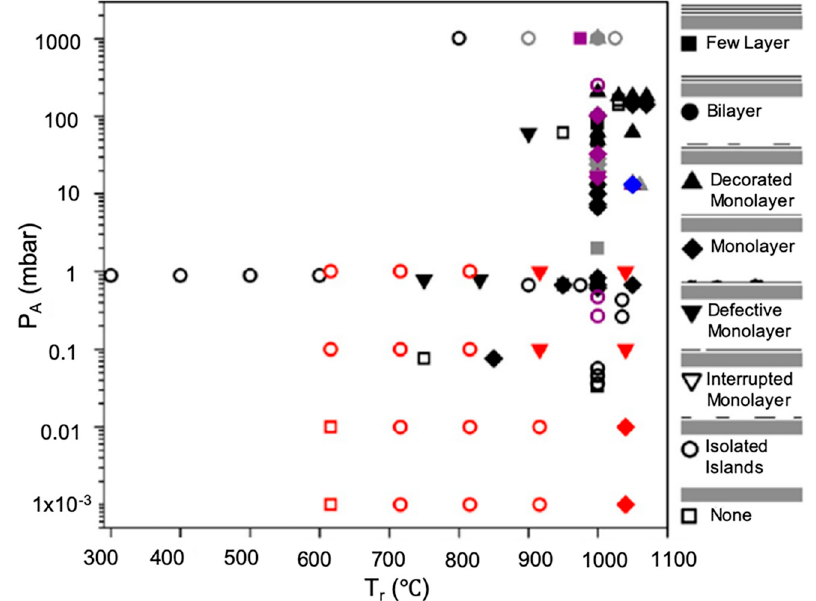
Figure 5. Coverage type for CVD of graphene versus growth temperature and pressure of active species as reported in the literature and Lewis et al. study. The data points span a range of different R CH denoted by the color: black: 1 > R CH > 0.1; gray for 0.1 > R CH > 0.01; purple for 0.01 > R CH > 0.001 and blue for 0.001 > R CH > 0.0001. The red data points correspond to the work done by Lewis et al., where R CH = 0.2 (reprinted with permission from [65]).